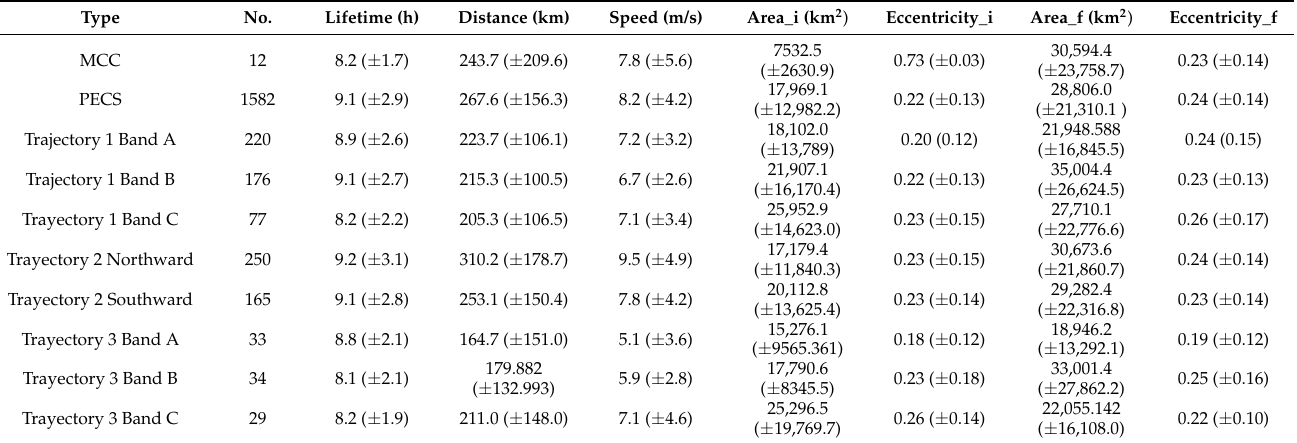
Table 6. MCS characteristics in the study region during the summers of 1995-2017. Means and ± one standard deviation (